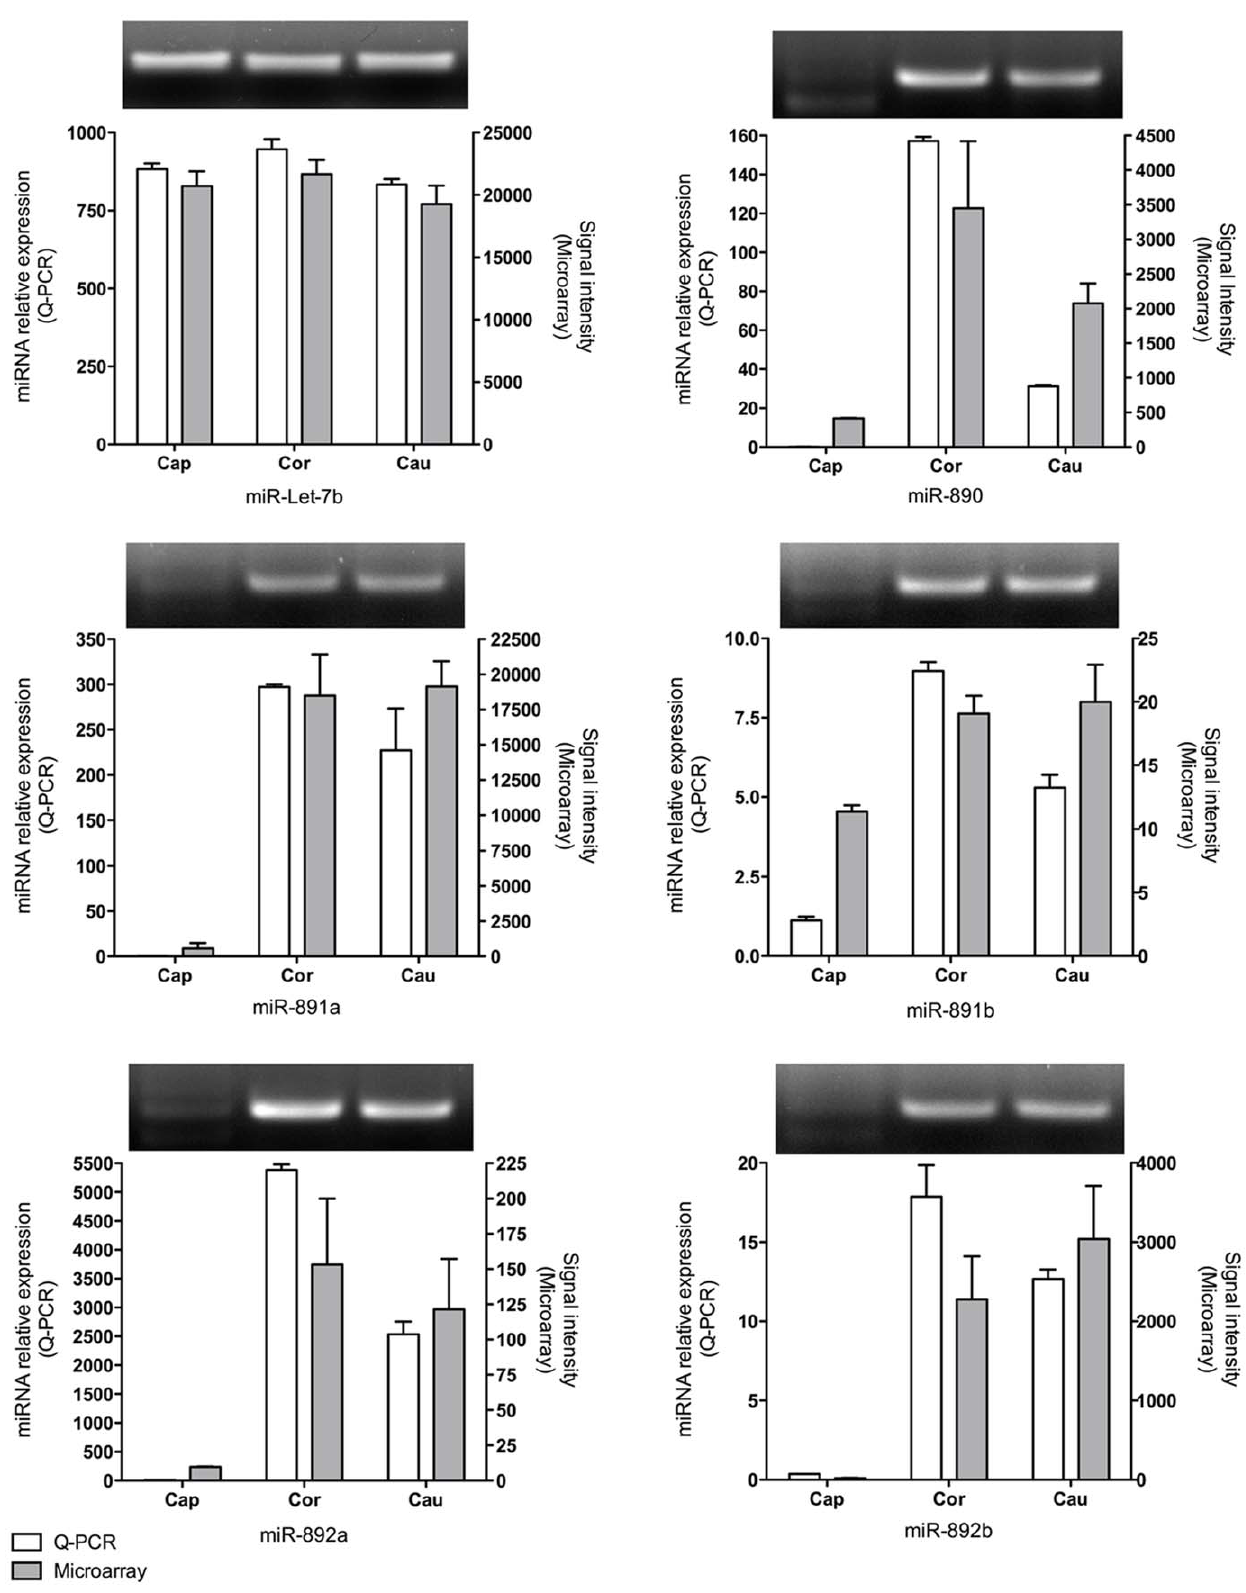
Figure 4. Expression of the miR-888 cluster family confirmed by end-point and real-time PCR. The expression of miR-890, miR-891a, miR- 891b, miR-892a and miR-892b was assessed in total RNA extracts from the human caput, corpus and cauda epididymis from three donors. Results obtained by real-time PCR (Q-PCR) were compared with the data obtained in the microarray study (microarray). Real-time PCR data were normalized